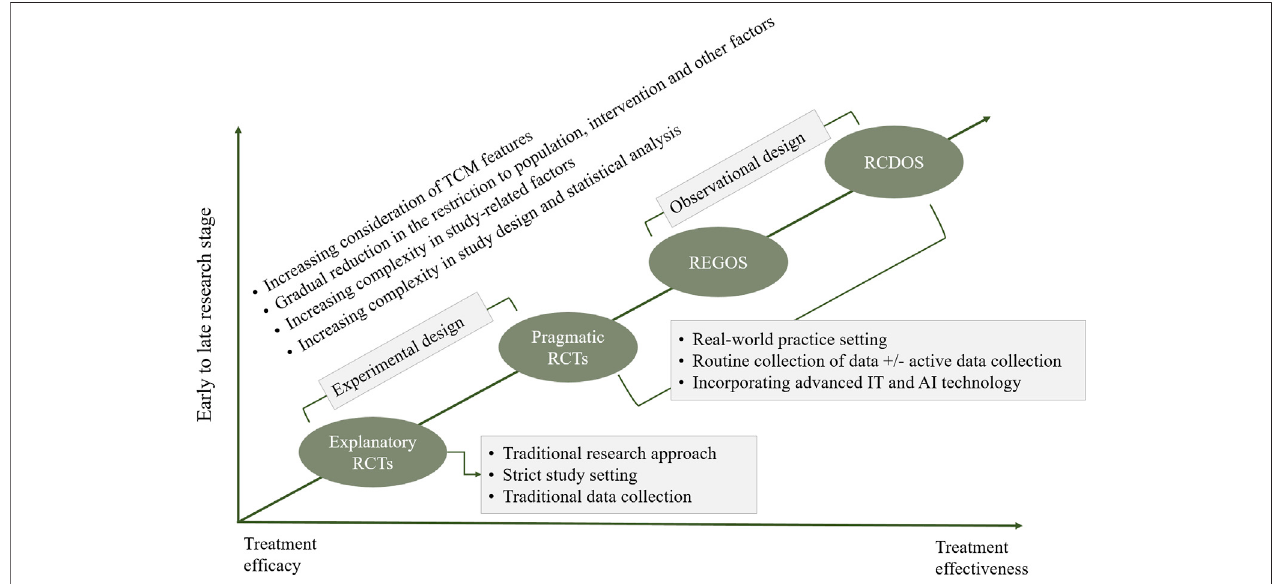
FIGURE1 | Integrated approach for assessing clinical effectsof traditional Chinese medicine (i.e., 4R approach). Notes: eRCT, explanatory randomized controlled trial; pRCT, pragmatic randomized controlled trial; RCDOS, observational studies using routinely collected data; REGOS, observational studies using patient registry data; IT, information technology; AI, arti fi cial